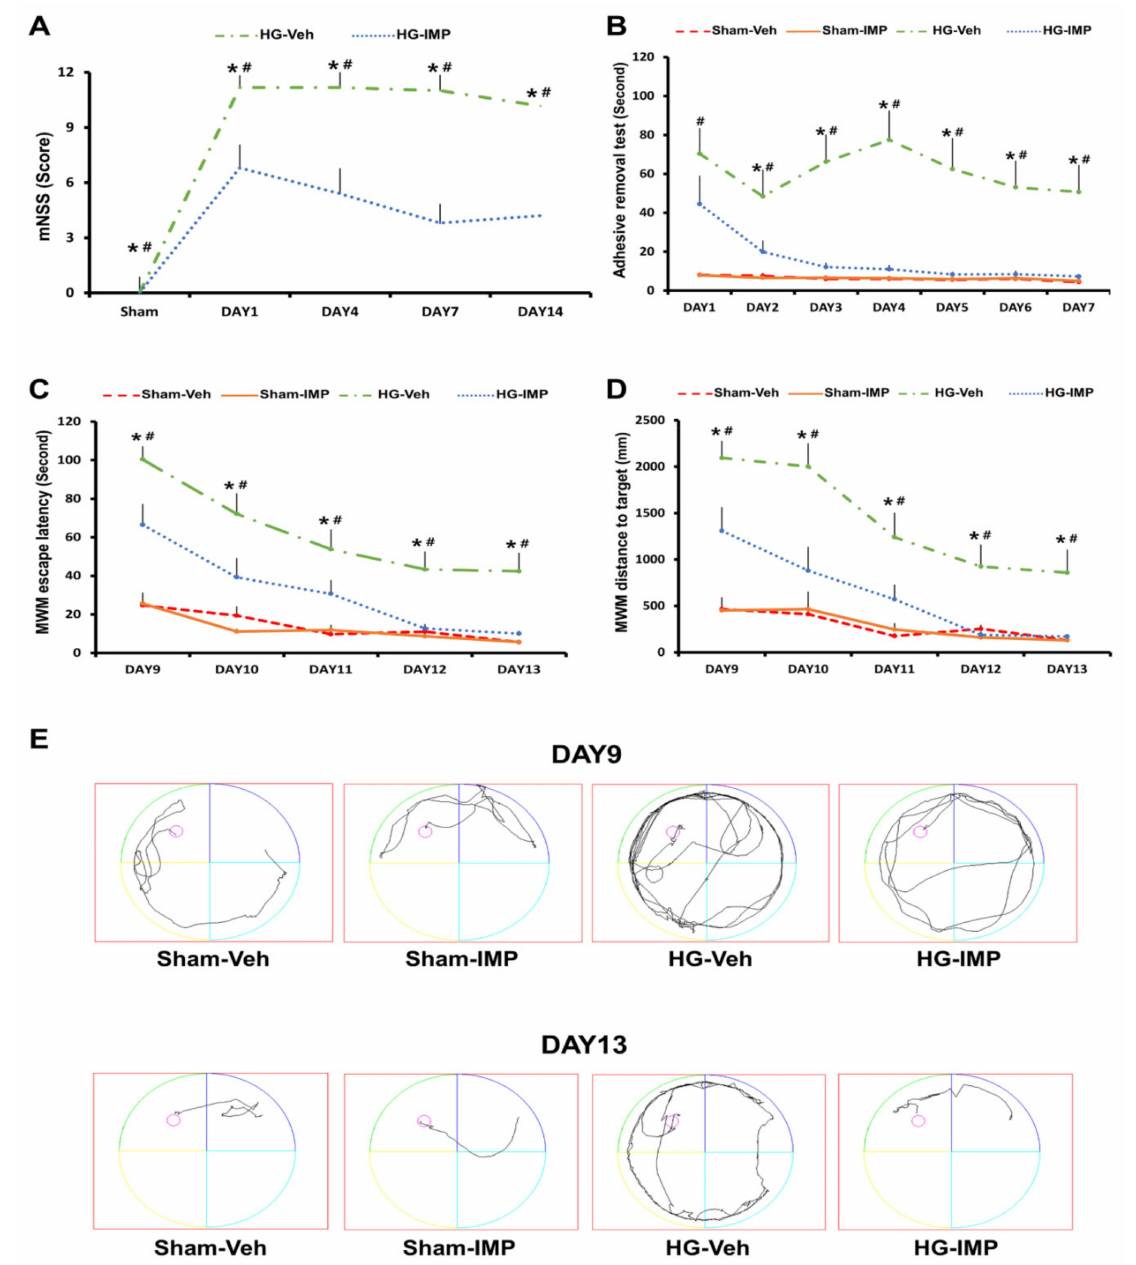
Figure 7. Administration of imipramine improved neurologic and cognitive function after hypo- glycemia: ( A ) the mNSS was scored in rats at 1, 4, 7, and 14 days after hypoglycemia. A score of 18 indicated that all trials had failed; a score of 0 indicated that all trials were completed. ( B ) ART perfor- mance test for 1 week: the imipramine-treated group removed the tape faster than the vehicle-treated group after hypoglycemia. ( C – E ) The MWM performance test. ( C ) The target platform arrival time for 5 consecutive days starting post-injury day (PID) 9. ( D ) The distance to target: the imipramine-treated group had a shorter distance to reach the target over time than the vehicle-treated group. ( E ) The average tracking record of each group reaching the target. Data are the mean ± SEM; n = 3 for each sham group. n = 5–7 for each hypoglycemia group. * Significantly different from the vehicle-treated group at p < 0.05, # significantly different from the sham-operated group at p <